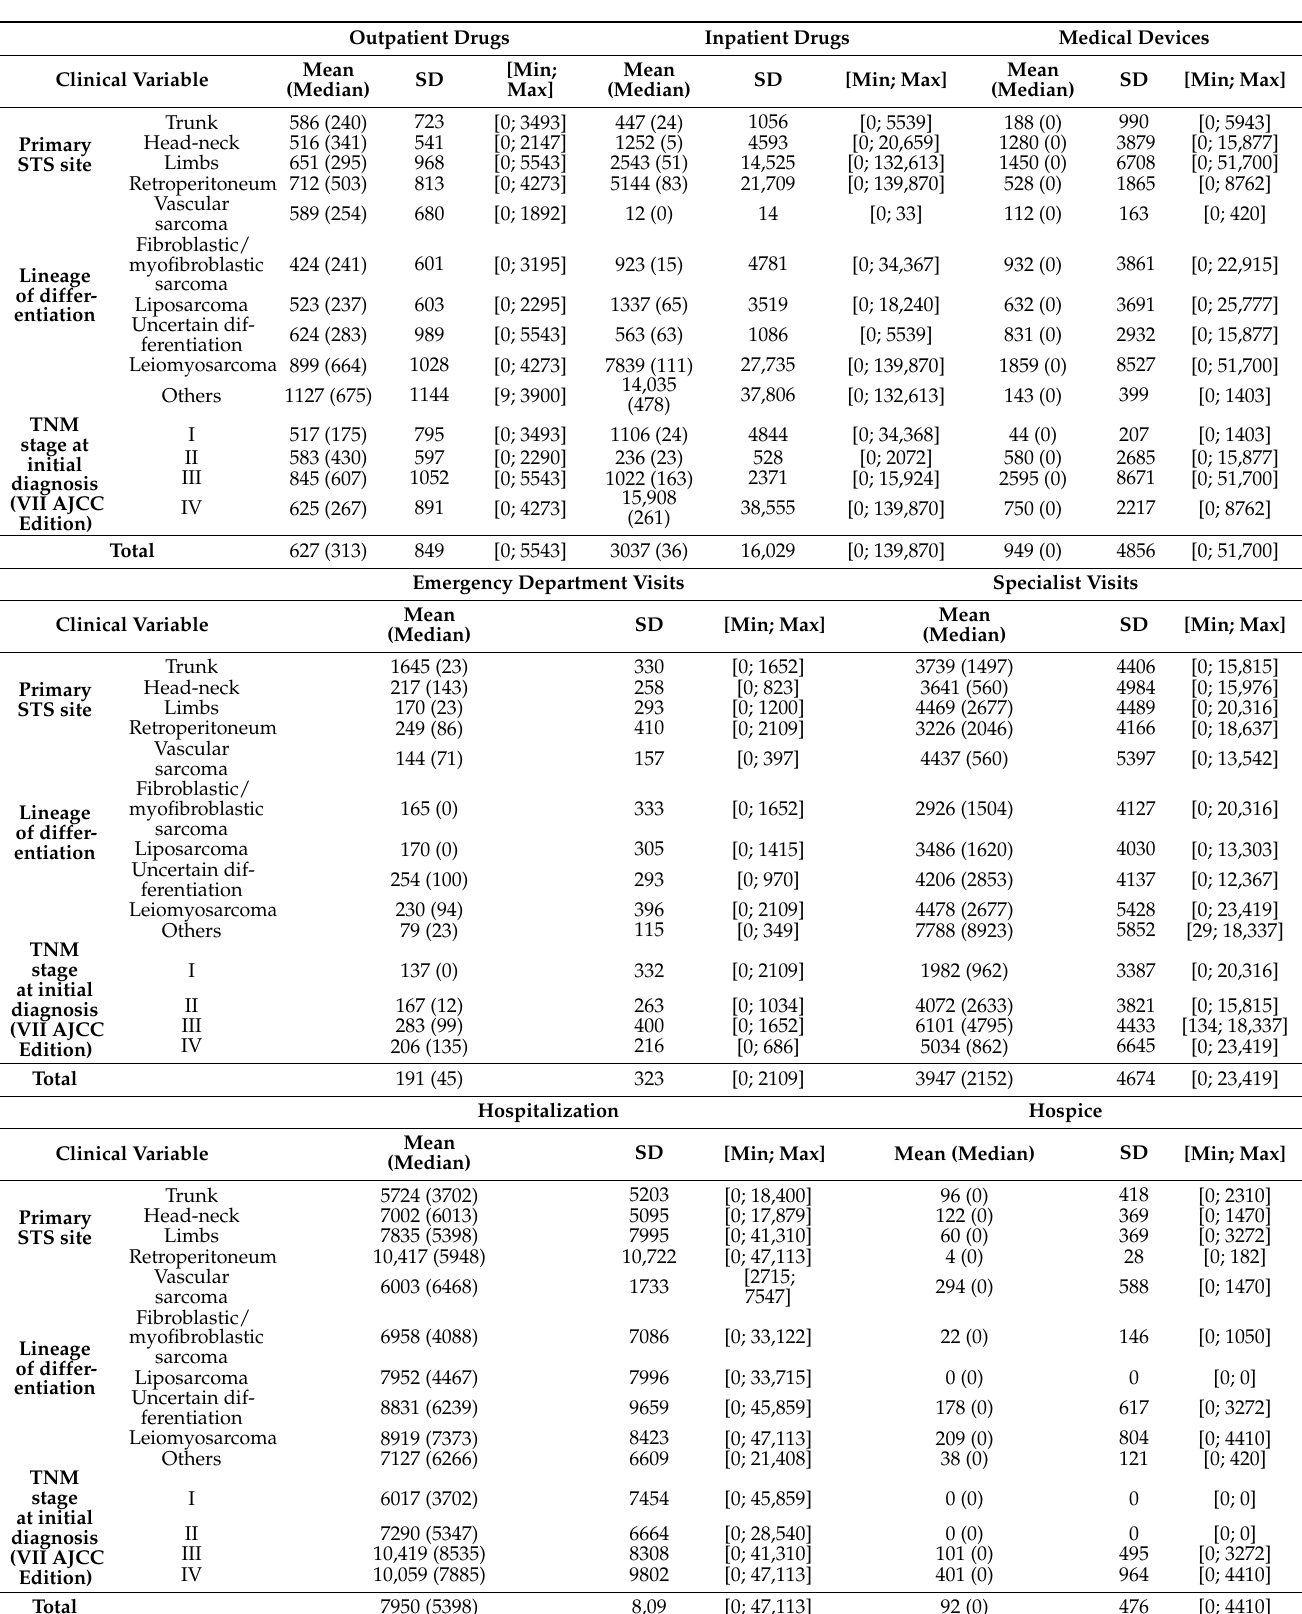
Table 3. Survival- unweighted costs (in EUR) of specific items in the two years after diagnosis. Outpatient Drugs Inpatient Drugs Medical